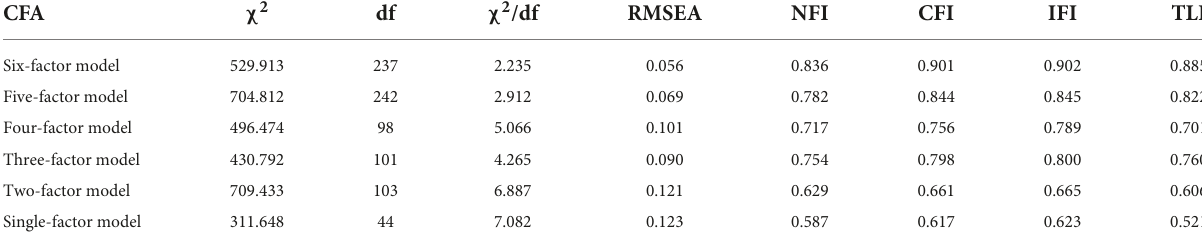
TABLE 1 Fit indices of CFA.